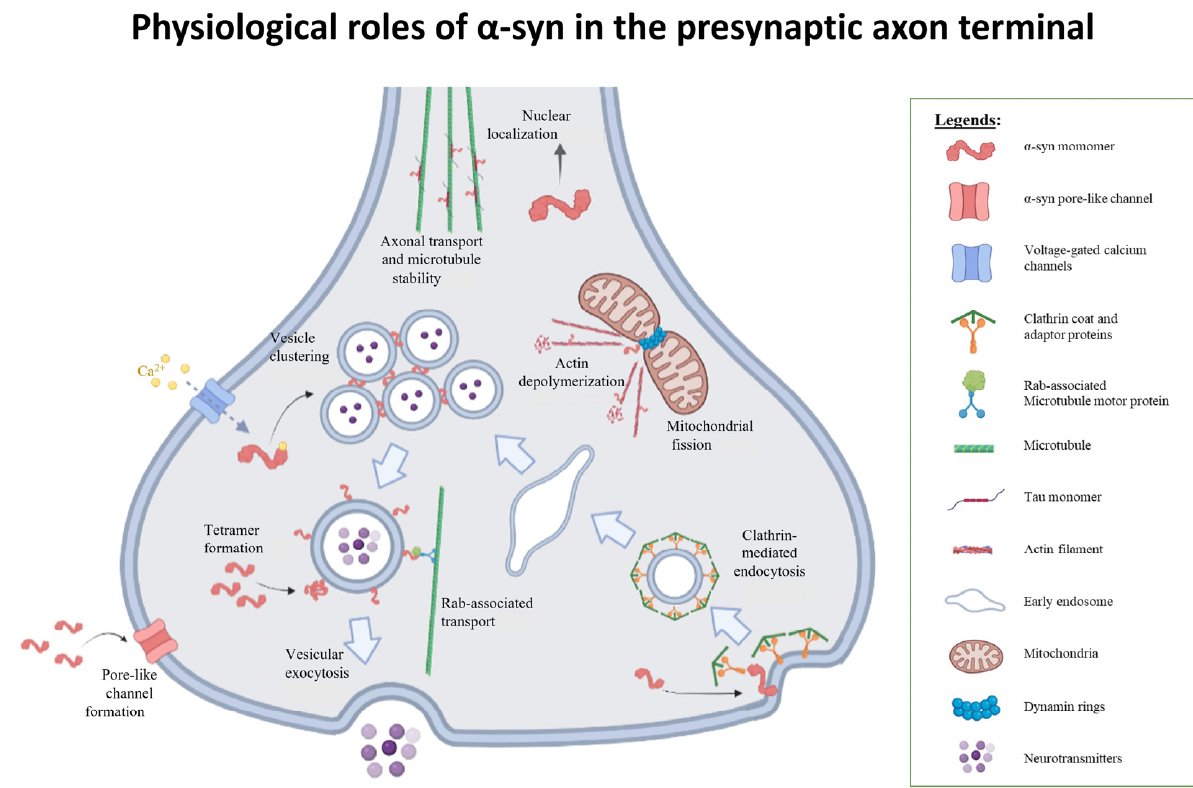
Figure 2. Physiological roles of α -syn in the presynaptic axon terminal. α -syn plays pivotal roles in the presynaptic axon terminal participating in vesicular clustering [12,18,43], recycling process, such as exocytosis and endocytosis [43,44,48,50–52], microtubule alterations [39], as well as maintaining mitochondrial fusion and fission dynamics through cytoskeletal reformation [99–101,114]. Figure is created with